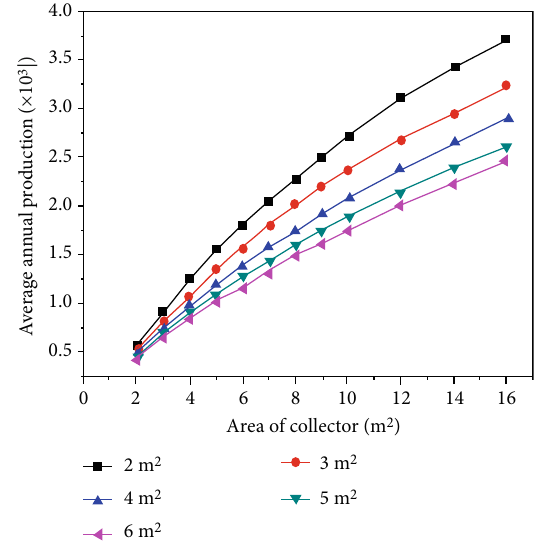
Figure 27: E ff ect of the collector area on the fresh water production